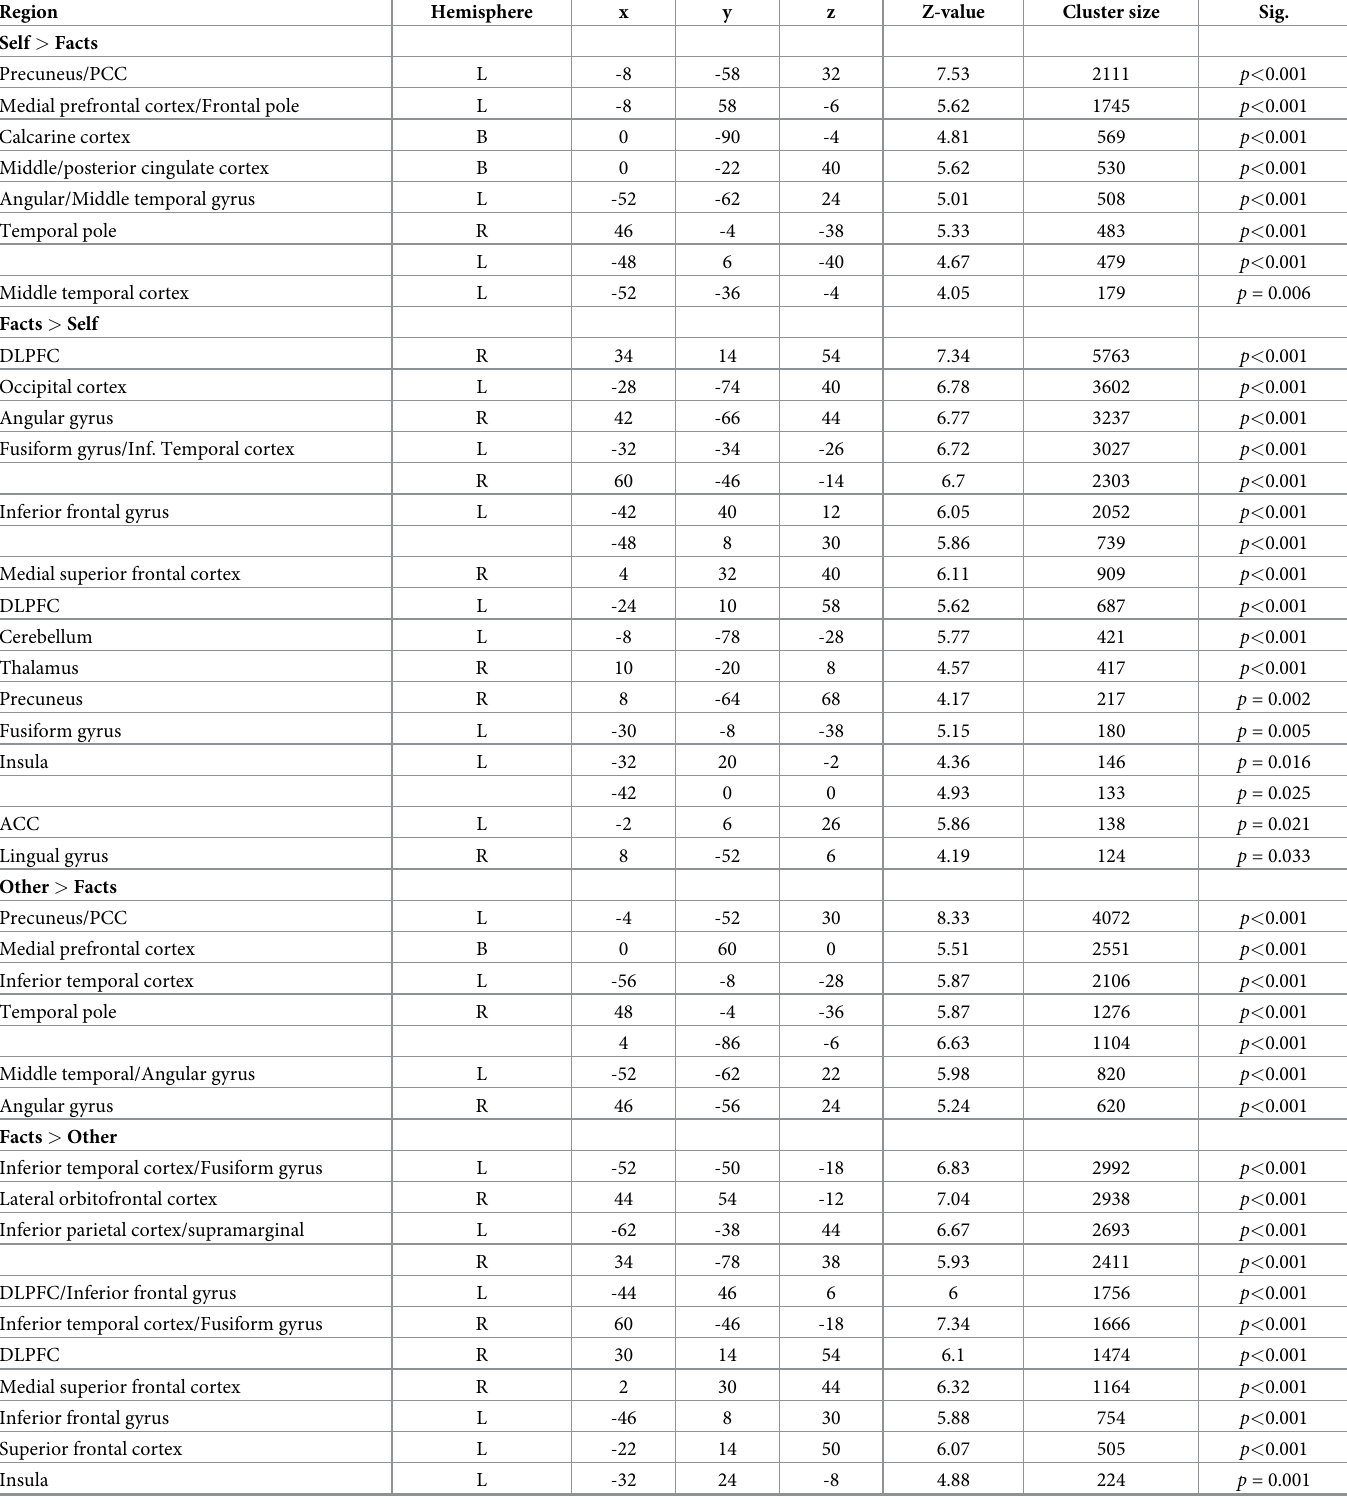
Table 3. Significant activation in the self-reflection